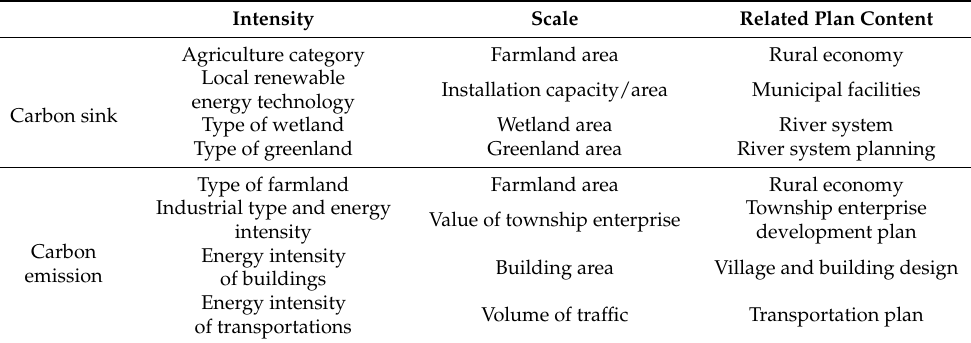
Table 1. Relationship between carbon emissions and village planning